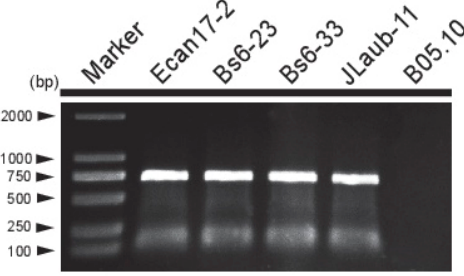
Figure 4. RT-PCR detection of Botrytis cinerea mymonavirus 1 (BcMyV1) in five B . cinerea strains. Strains Ecan17-2 and B05.10 served as positive and negative controls, respectively.